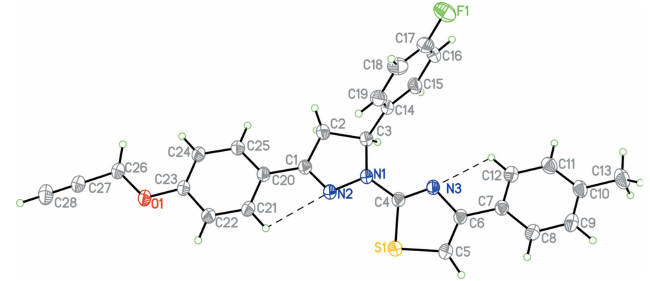
Figure 1 Perspective view showing the molecule and atom labelling. Intra- molecular C—H (cid:4)(cid:4)(cid:4) N interactions are shown as dashed lines. Displace- ment ellipsoids are drawn at the 30% probability